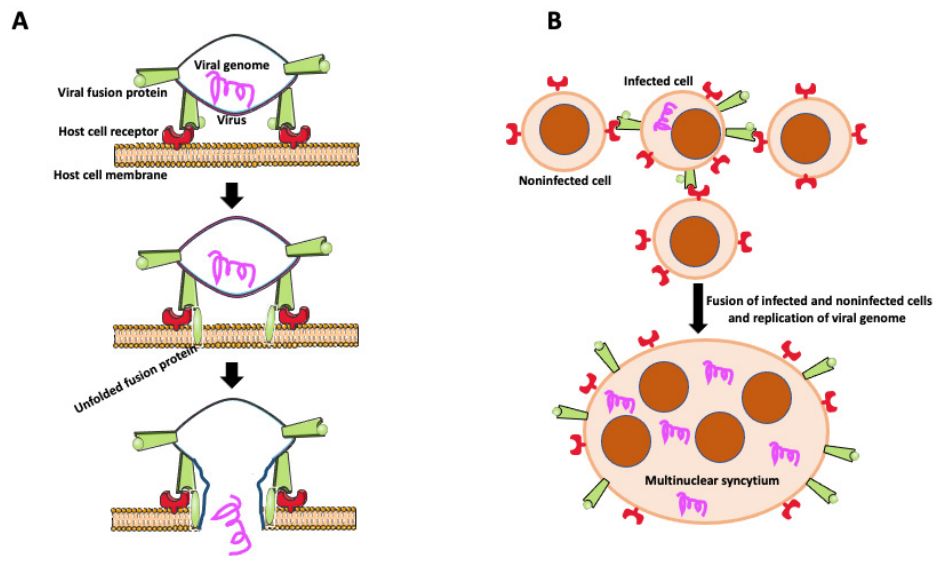
Figure 4. Virally induced fusion. ( A ) Fusion of the virus with the host cell membrane. Fusion of virus with the host cell membrane. Virus envelope contains fusion protein, which is recognized by receptors on the host cell membrane. After binding to its receptor, viral fusion protein unfolds, causing membrane scission and allowing the viral genome to enter the host cell. ( B ) Virally induced fusion of host cells. An infected cell expresses viral fusion protein on its surface. Fusion protein binds to its receptor on the surface of the noninfected cells promoting cell fusion. Resulting multinuclear syncytium replicates the viral genome, becoming the virus’s reservoir and facilitating the virus’s further spreading.